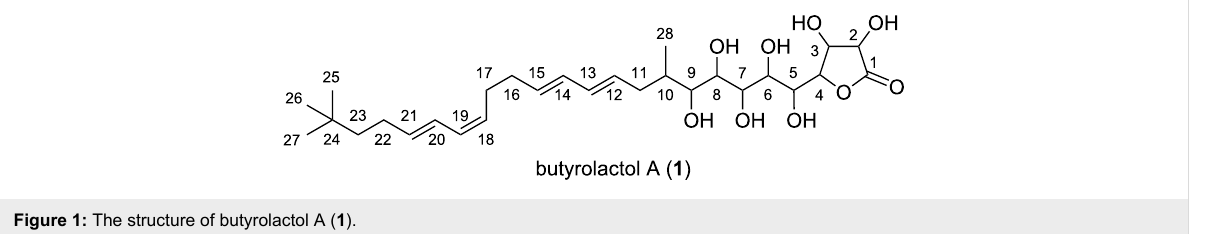
Z -olefin with a terminal tert -butyl group, whereas the hydro- philic polyol system bearing a γ -lactone terminus constitutes the right half of the molecule. To date, no structurally related natural products are known except for its demethyl congener butyrolactol B that was also isolated from the same strain and has an isopropyl group instead of the tert -butyl terminus